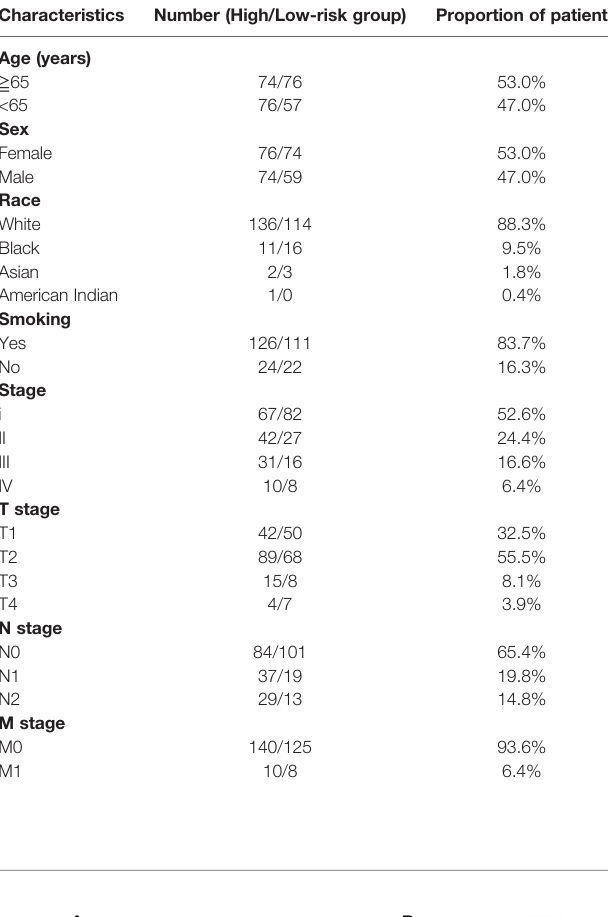
TABLE 1 | Clinical characteristics of patients in high- and low-risk subgroups (TCGA, n=283).